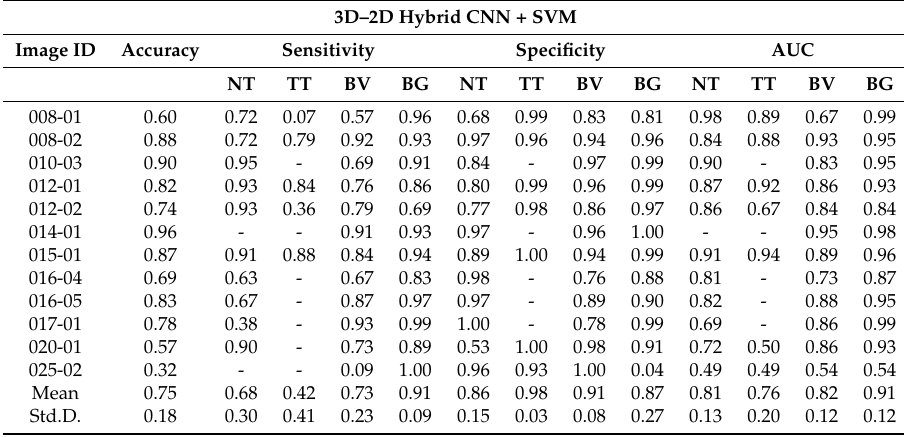
Table A2. Overall results for the 3D–2D hybrid CNN + SVM applied to the features extracted with the hybrid model. Accuracy, sensitivity, specificity, and AUC are calculated for each class. NT: Normal tissue, TT: Tumor tissue, BV: blood vessels, BG: